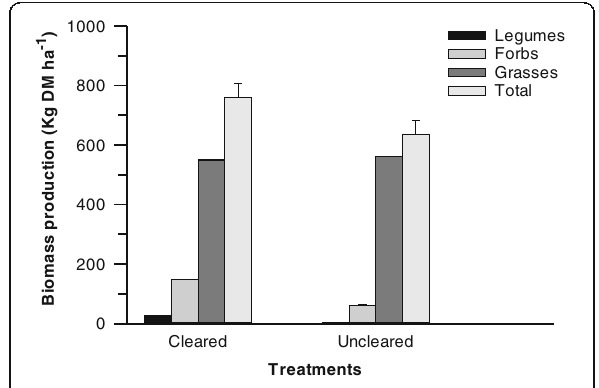
Fig. 4 The mean biomass production of various herbaceous functional groups in cleared and uncleared sites. Bars indicate the mean values, and the whiskers indicate the standard errors